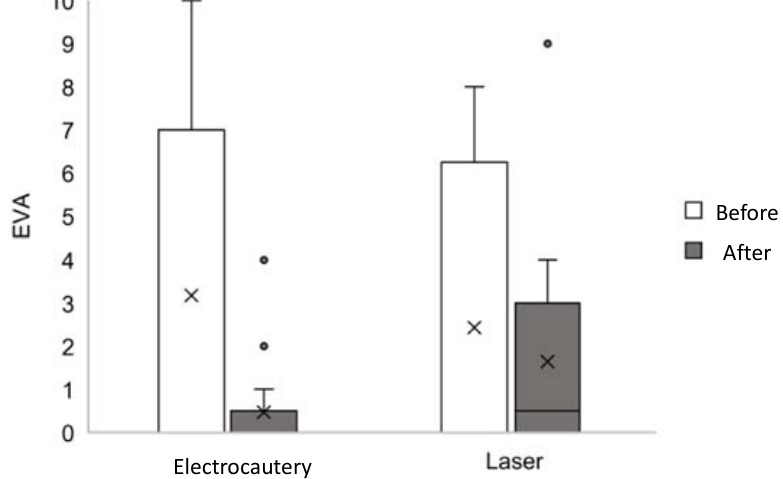
Figure 4. Visual analogue scale for mother’s pain during breastfeeding .